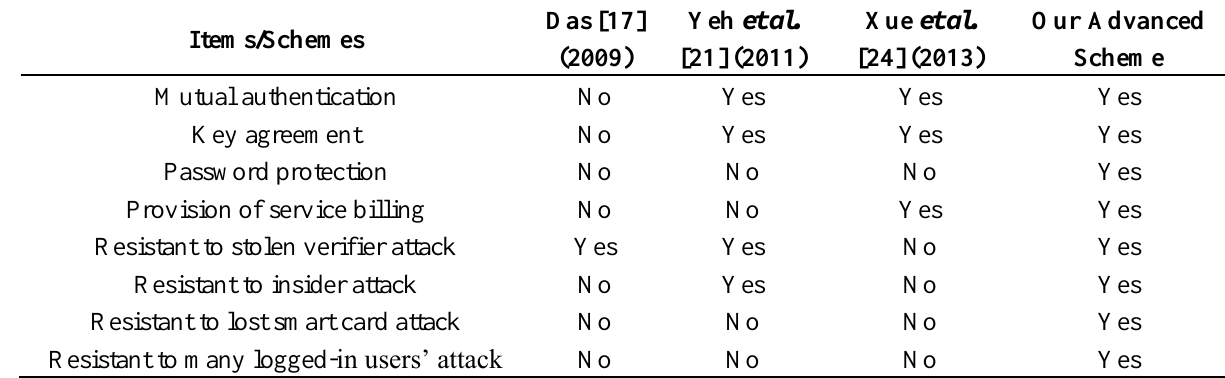
Table 4. Functionality comparisons of our advanced scheme and related schemes.